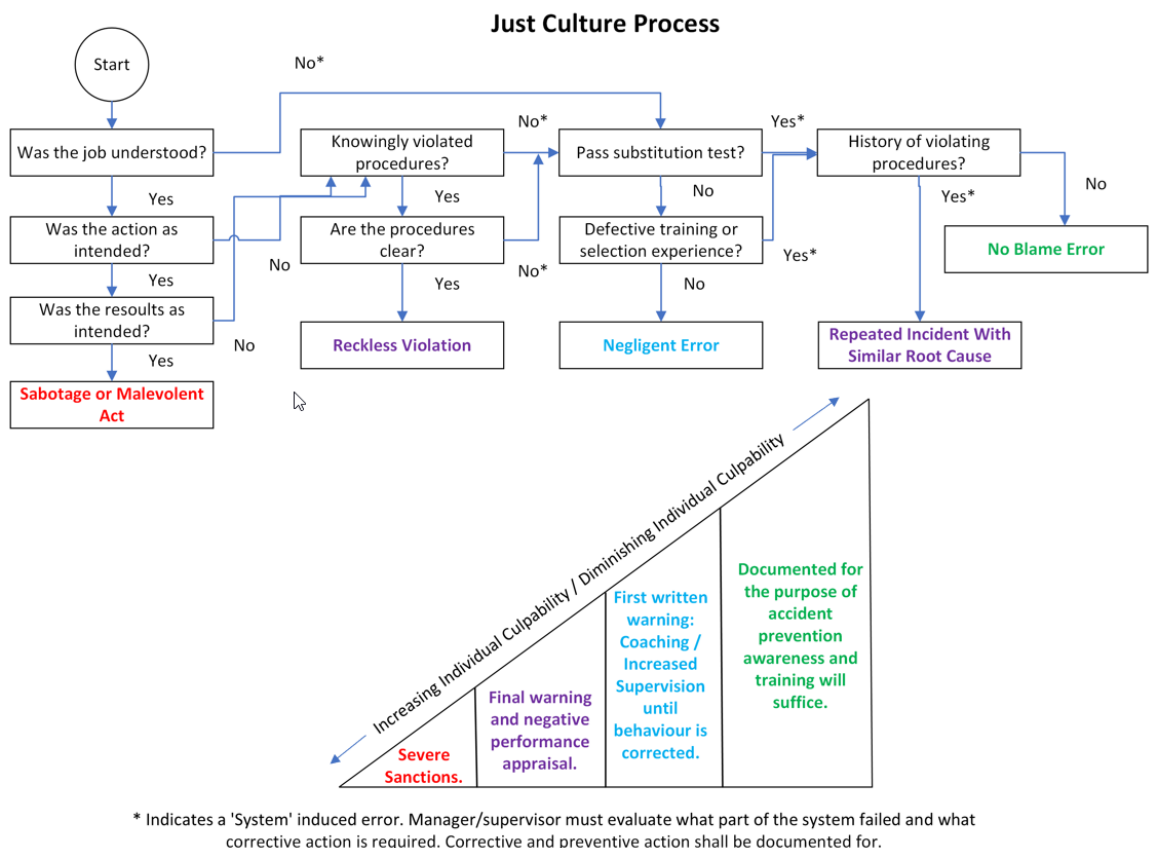
Figure 3. The Just Culture process (source: [6]). It is vital to develop the safety culture mindset in the entire society, not only within specific hazard prevention teams. Timely customer reporting (e.g., waterspout or tornado) from the ground may help avoid other unwanted